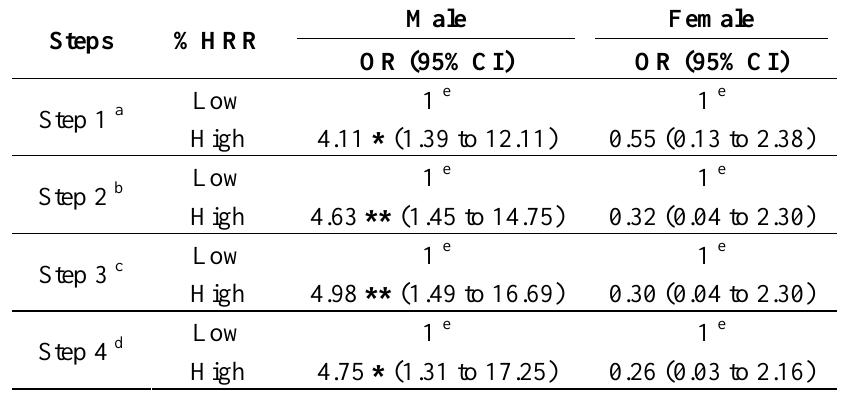
Table 3. Logistic regression model estimating the association between heart rate reserve measured for 3–4 days and reduced work ability among males ( n = 75) and females ( n = 53).